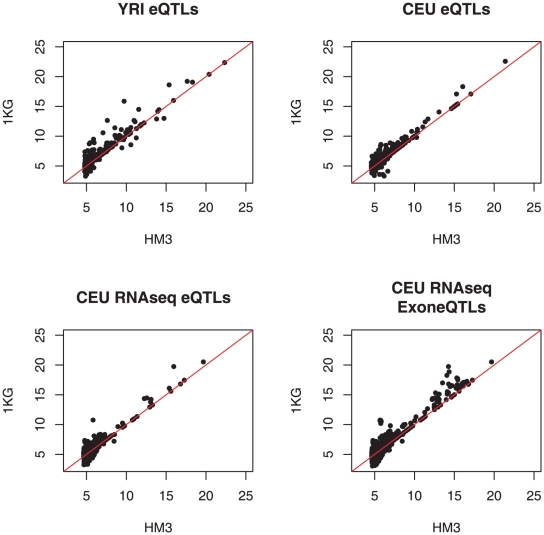
Fine mapping of HapMap 3 eQTLs into 1000 genomes variants.For eQTLs discovered with HapMap 3 (HM3) variants we assessed the best p-value of a variant in linkage disequilibrium (D′≥0.8) with the HapMap 3 variant in the 1000 genomes (1KG). This discovery was compared for all populations and expression platforms and in between exon and gene eQTLs for the RNA-Seq data. We found that usually a better association was uncovered in 1KG, suggesting that we are more likely to be observing the causal variant. For CEU-eQTLs (top right panel) discovered using arrays, 189 of 398 associations were better in the 1000 genomes (only 34 worse). For YRI-eQTLs (top left panel) discovered using arrays, 187 of 427 associations were better in the 1000 genomes (28 worse). For CEU gene and exon-eQTLs discovered with RNA-seq, 362 of 821 were better in the 1000 genomes (129 worse) and 1130 of 2598 were better (371 worse), respectively.